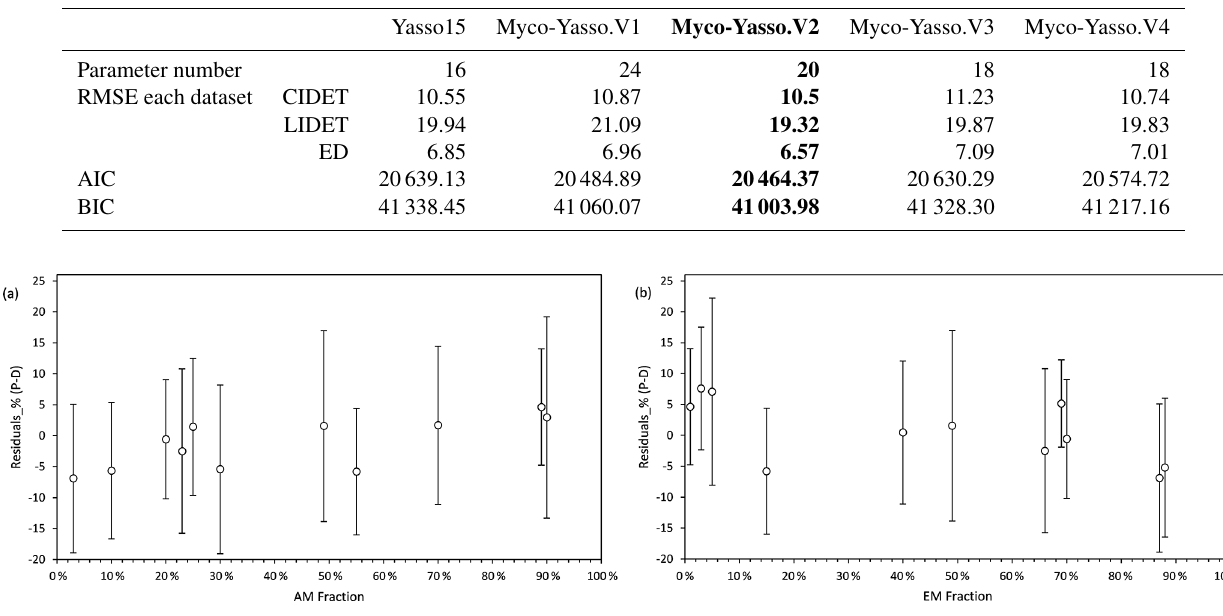
Figure 4. Standardized residuals (predictions – measurements, P–M) of decomposition, expressed as percent mass loss, modelled by Myco- Yasso as a function of the abundance of AM mycorrhizal plants (a) and EM mycorrhizal plants (b) in vegetation. The circle in the middle of each line is the mean value of the residuals. The intervals contain residuals within 95% probability intervals.